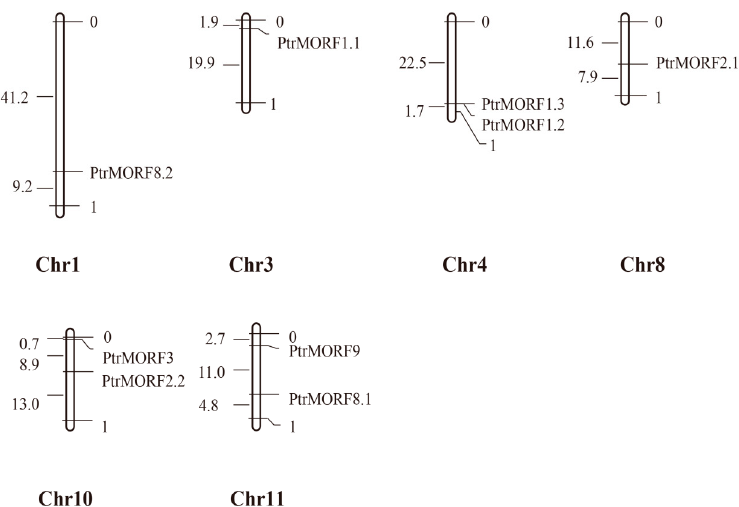
Figure 4. Chromosomal locations of Populus MORF family members. The chromosomal locations of the MORF genes were mapped with MapDraw program. The number to the left of each chromosome represented the size of the chromosome in Mbp.